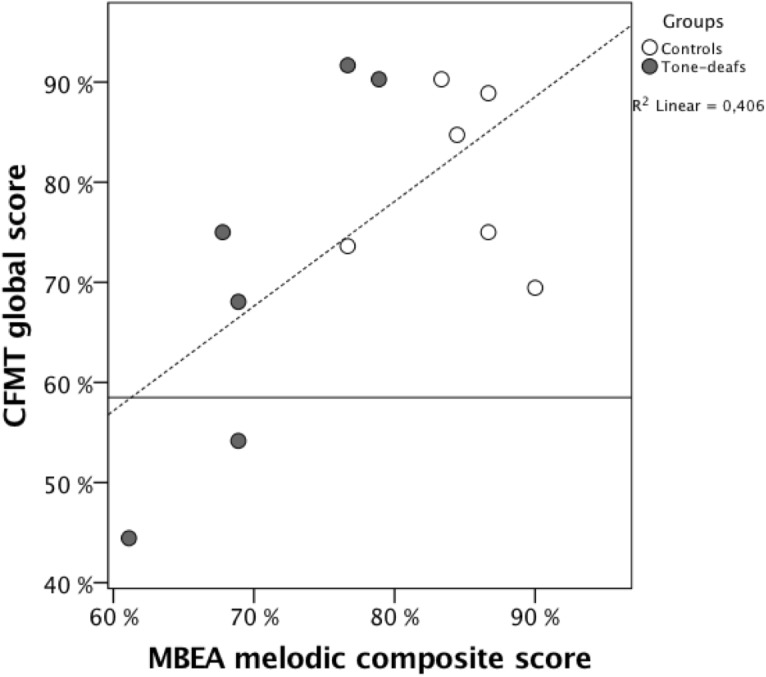
Representation of the participants CFMT global scores (Y) and MBEA melodic composite score (x) presented by groups: Tone-deaf subjects (black) and control subjects (white). The horizontal line represents the CMFT cut-off presented in text.